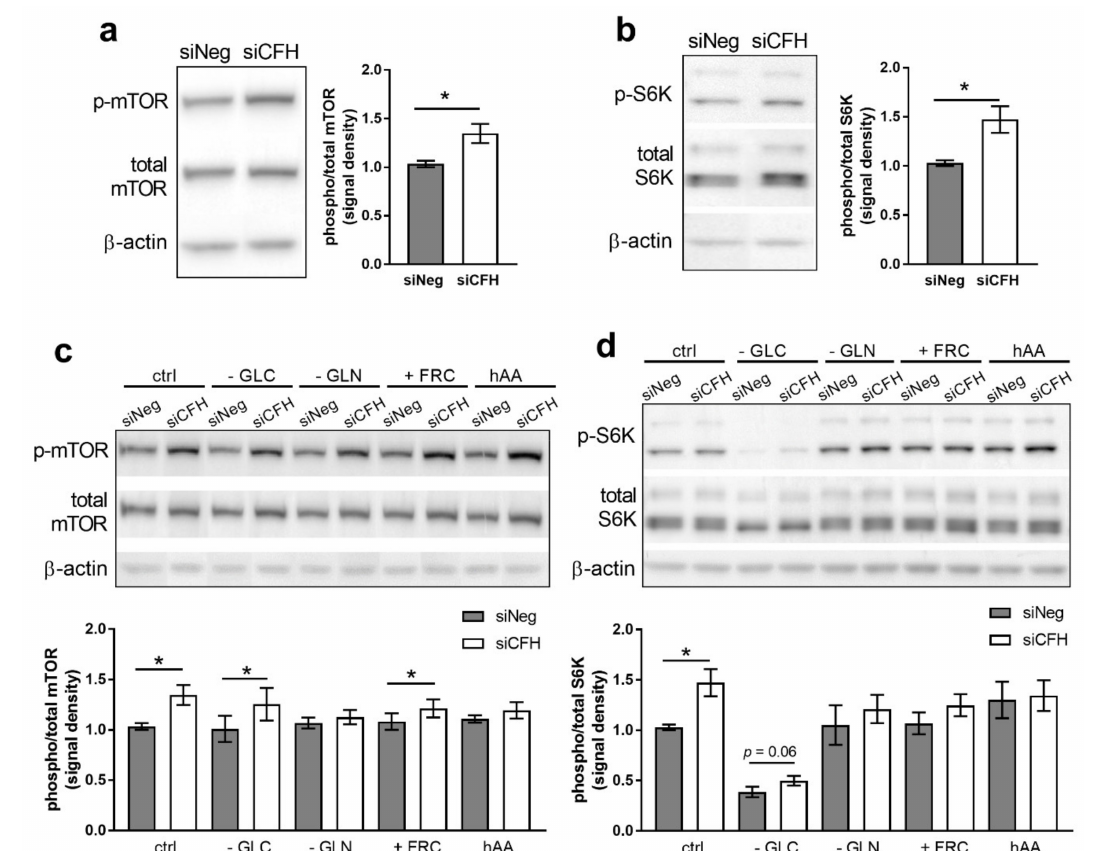
Figure 1. FH knockdown leads to mTOR pathway activation in RPE cells. The hTERT-RPE1 cells were silenced for 24h with negative control (siNeg) or CFH specific (siCFH) siRNA and then incubated for 48 h in the indicated conditions. Cell pellets were collected for protein extraction. ( a , c ) Western blot analyses of phosphorylated and total levels of mTOR. Total β -actin was used as loading control. Quantification of at least four independent experiments is shown, where bars indicate the signal density ratio between levels of phosphorylated and total mTOR. ( b , d ) Western blot analyses of phosphorylated and total levels of S6K. Total β -actin was used as loading control. Quantification of at least four independent experiments is shown, where bars indicate the signal density ratio between levels of phosphorylated and total S6K. SEM is shown. Significance was assessed by Student’s t -test; * p < 0.05. GLC, glucose; GLN, glutamine; FRC, fructose; hAA, high